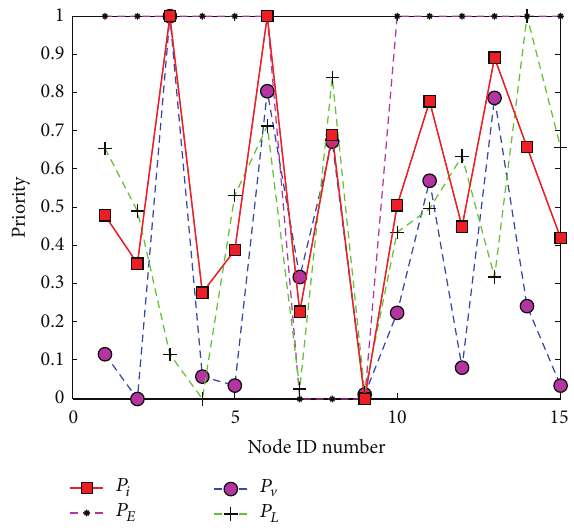
Figure4:SHelectionpriority.NodewiththeleastEPF( 𝑃 𝑖 )iselected as a SH (ID =